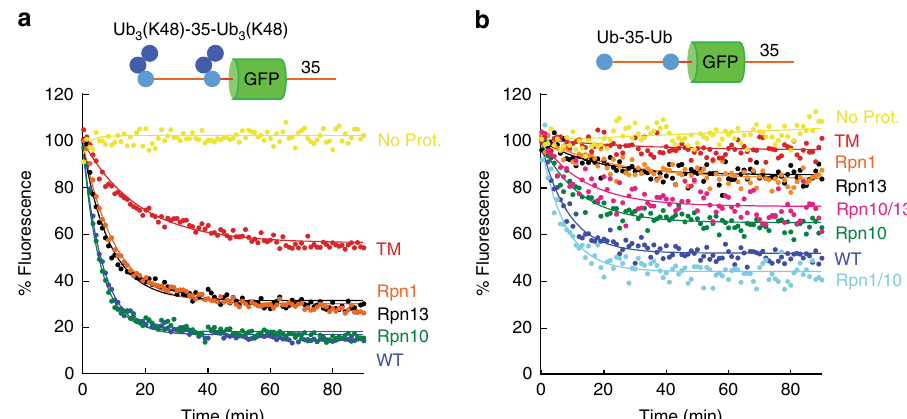
Fig. 7 Degradation of multi-ubiquitinated substrates. Degradation of substrate proteins modi fi ed with two K48-linked ubiquitin chains or bearing two co- translated single ubiquitin domains by the indicated proteasome types was followed under single-turnover conditions (5 nM substrate, 25 nM proteasome) in the presence of 1 mM ATP at 30 °C. The graphs show substrate fl uorescence as a percentage of the initial fl uorescence as a function of time in minutes. Proteasome types are described in Supplementary Table 1 (TM triple mutant proteasome). Each panel shows the degradation of particular substrates, and as follows: a Ub 3 (K48)-35-Ub 3 (K48)-GFP-35 and b Ub-35-Ub-GFP-35. Source data are provided as a Source Data